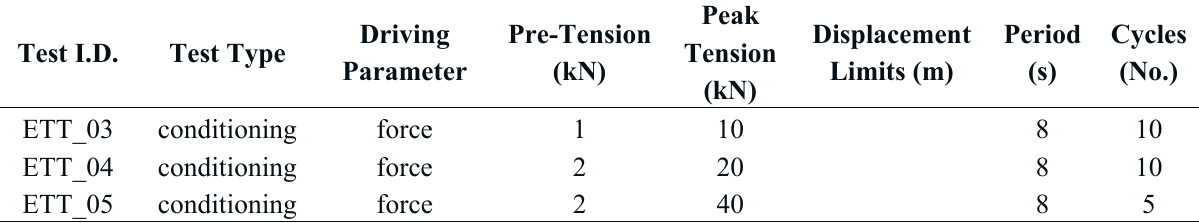
Table 2. Summary of the conditioning, primary data, and durability extension tests. Test